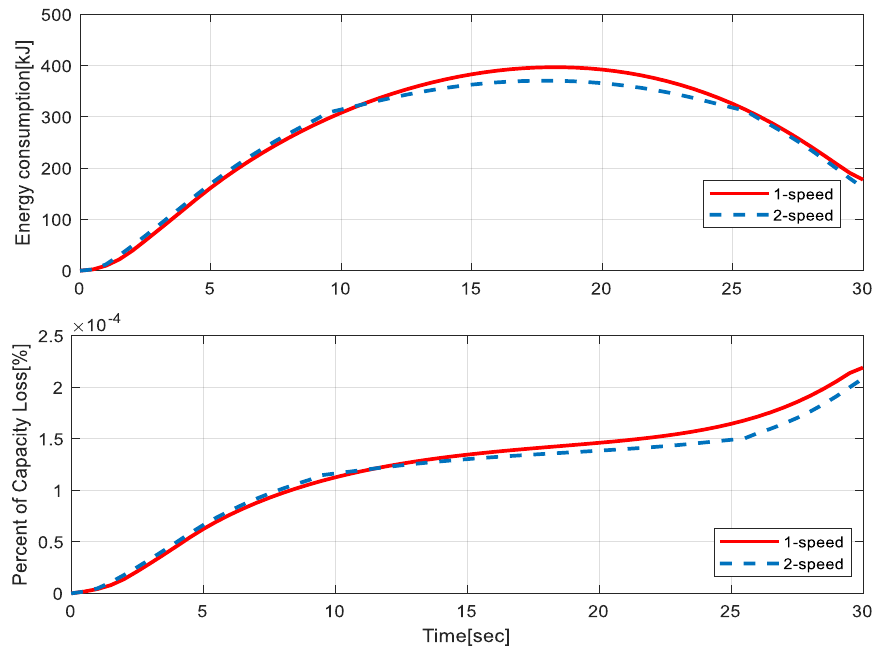
Table 6. Simulation results of different gearboxes.